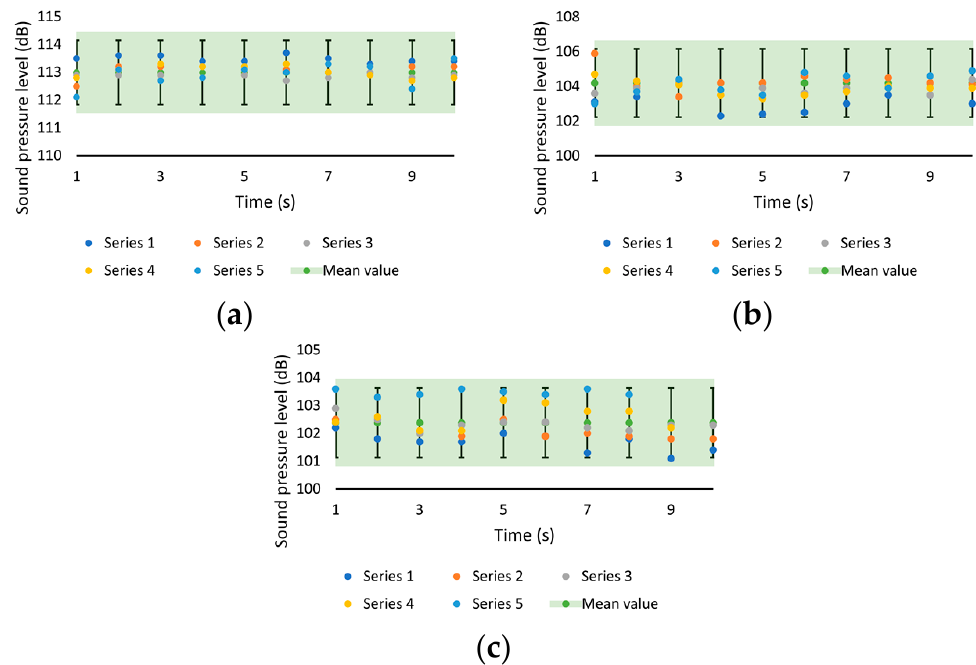
Figure 6. SPL dataset to assess the repeatability of the experiments for the standard nozzle, with data points collected at ( a ) 1, ( b ) 2 and ( c ) 4 m distance from the nozzle to the sound level meter. The plot includes individual data points and mean values calculated at each acquisi- tion, together with a band, the size of which is three times the maximum standard deviation calculated over the whole set of tests. All the data points lie within the highlighted band, which exhibits relatively high repeatability and low random error (i.e., high